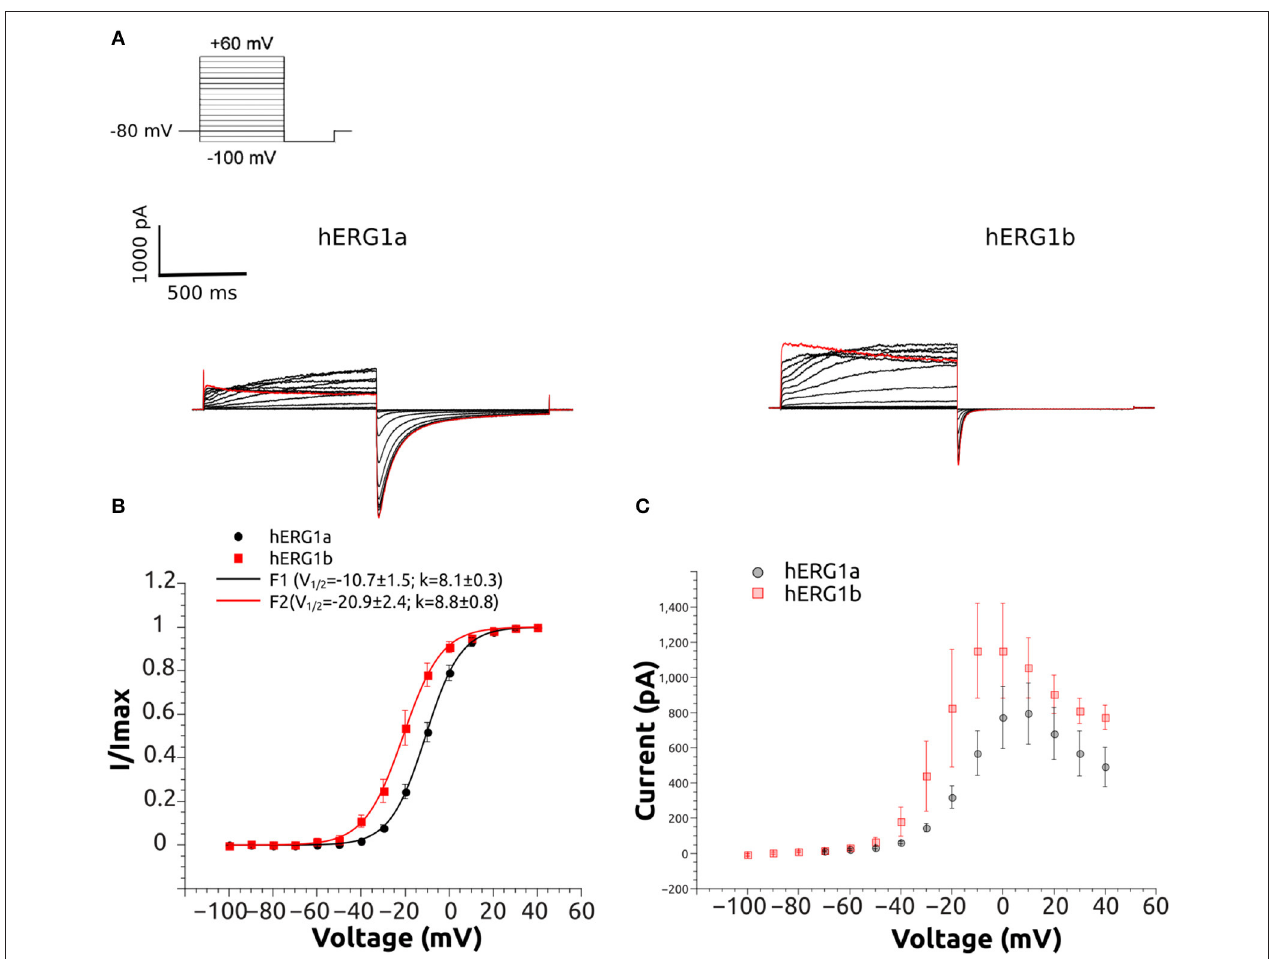
FIGURE 3 | Representative current traces of hERG1a and hERG1b channels and their current-voltage relationship at room temperature. (A) Selected current traces recorded from HEK cells and elicited by the voltage protocol shown in the top. (B) Normalized tail currents against voltage. The solid lines correspond to the fitted Boltzmann functions and symbols correspond to data. All data are listed as mean ± SEM. hERG1a ( n = 10), hERG1b ( n = 10). (C) Currents measured at the end of each step were used to construct the current-voltage (I-V) relationship. All data are shown as mean ± SEM. hERG1a ( n = 10), hERG1b ( n =